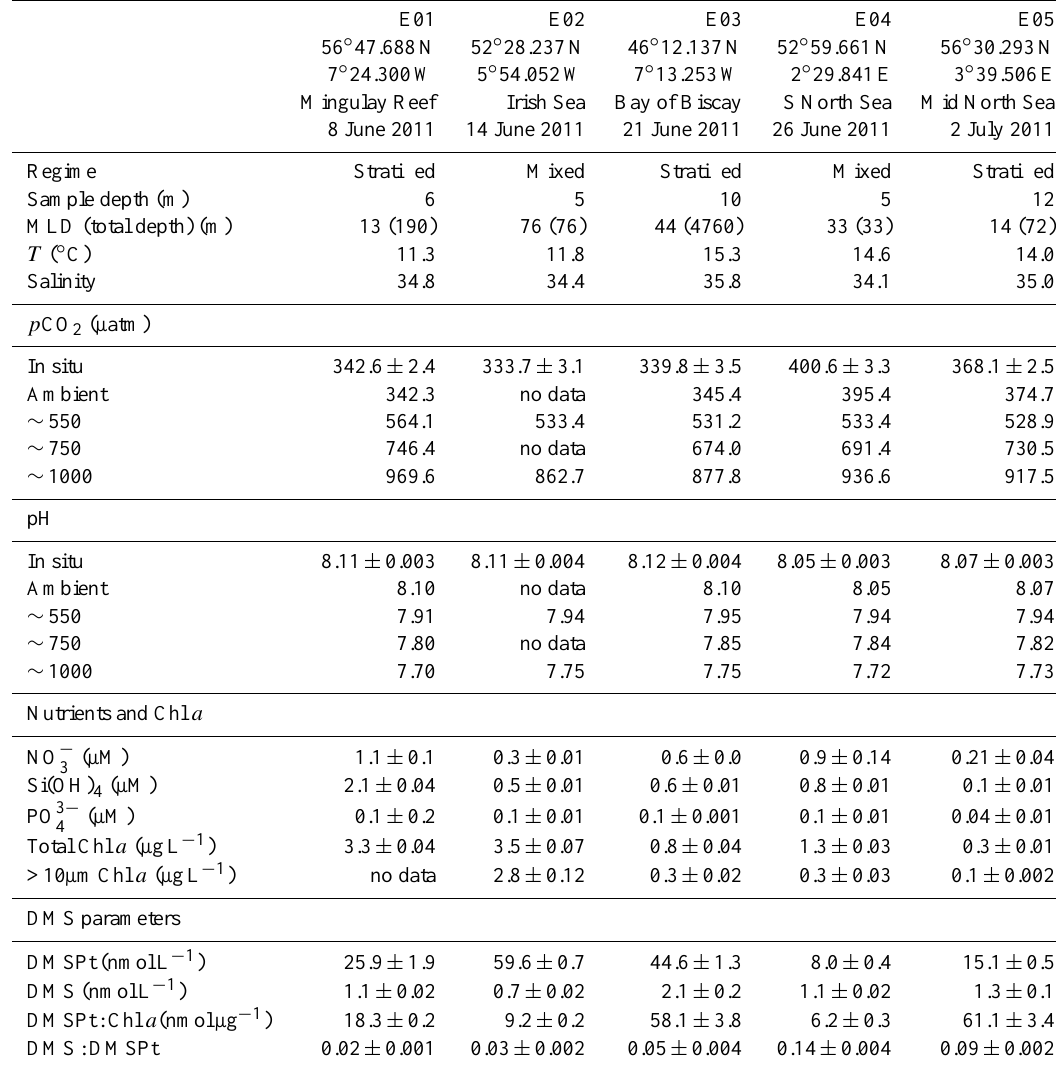
Table 1. Overview of initial conditions for experimental bioassays. MLD stands for mixed layer depth, DMSPt is total DMSP and DMSPp is particulate DMSP. Data shown are means ( ± standard error) for triplicate measurements made at 0h for each experiment. Standard errors are not shown for experimental p CO 2 and pH as values are based on single